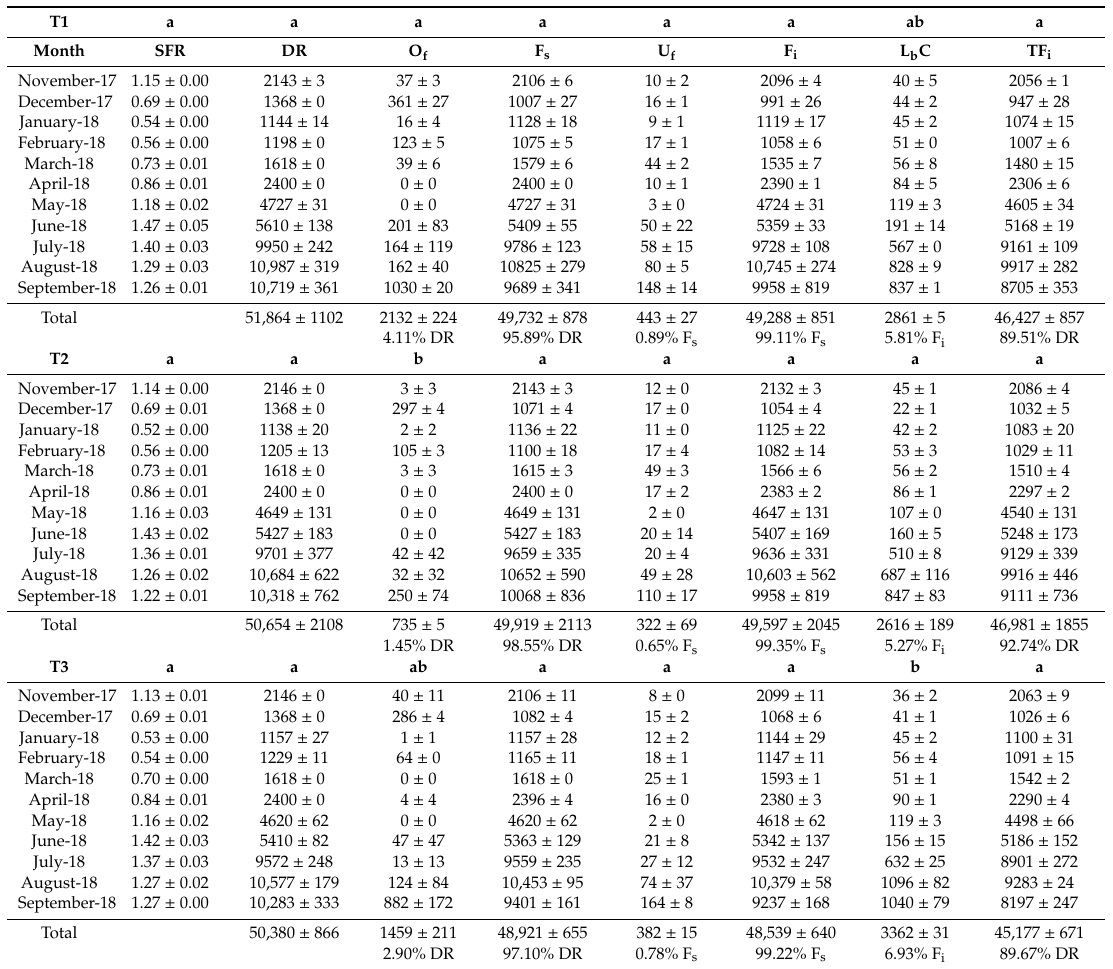
Table 4. Monthly (mean ± standard error) SFR (specific feeding rate, as % of fish body weight · day − 1 ) and feed fractions (in g) throughout the trial. DR: daily ration; O f : “overfeed” is the feed that would have been wasted if it had been supplied considering that the whole DR was delivered; F s : supplied feed (DR - O f ); U f : “uneaten feed” is the supplied but unconsumed feed; F i : feed intake (F s - U f ); L b C: feed lost by chewing; TF i : truly ingested feed (F i - L b C). Di ff erent letter over the column